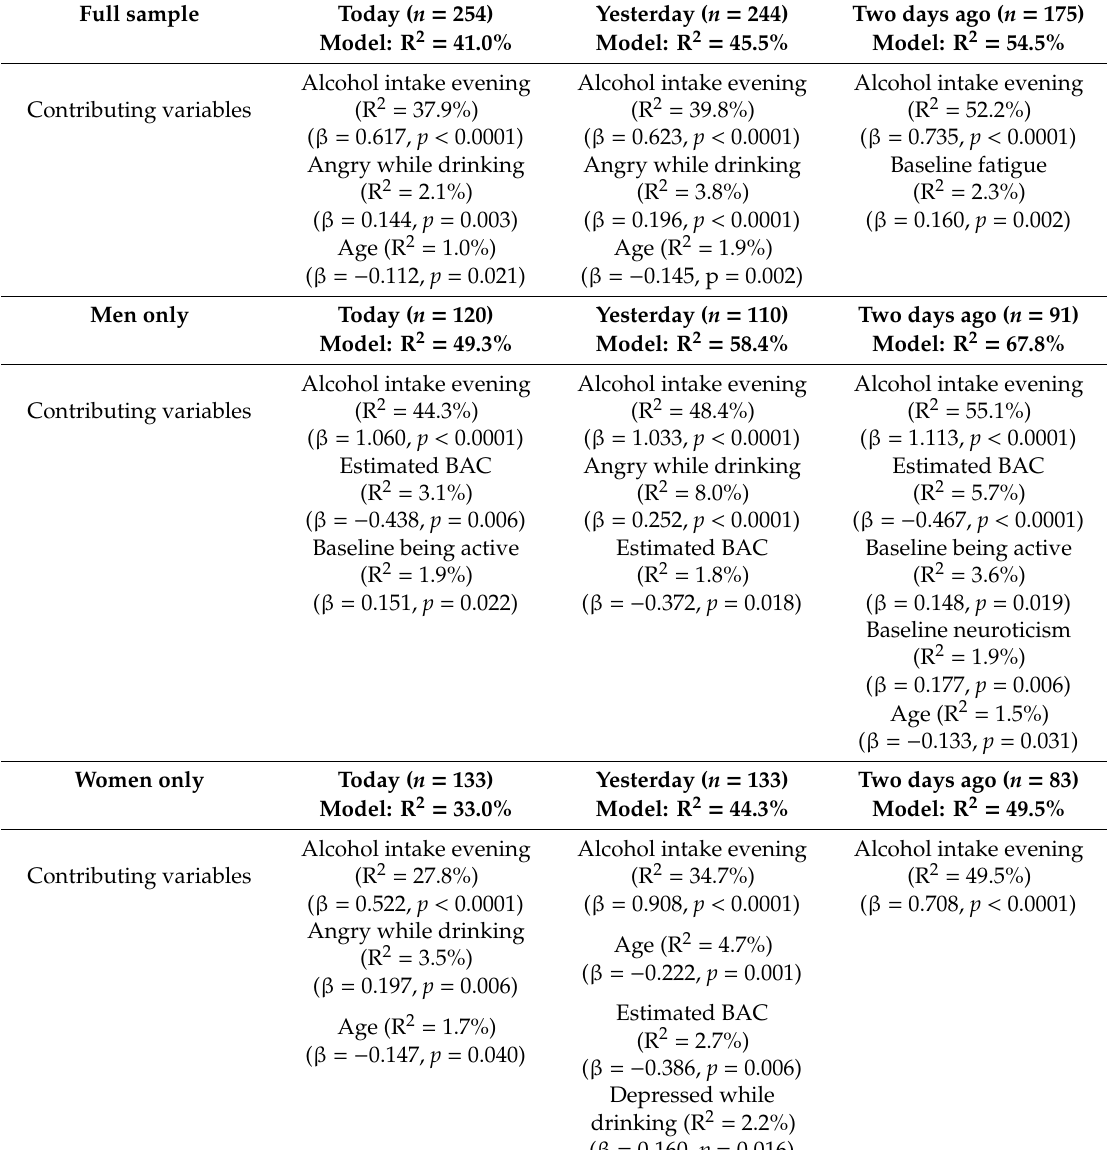
Table 6. Significant predictors of subjective